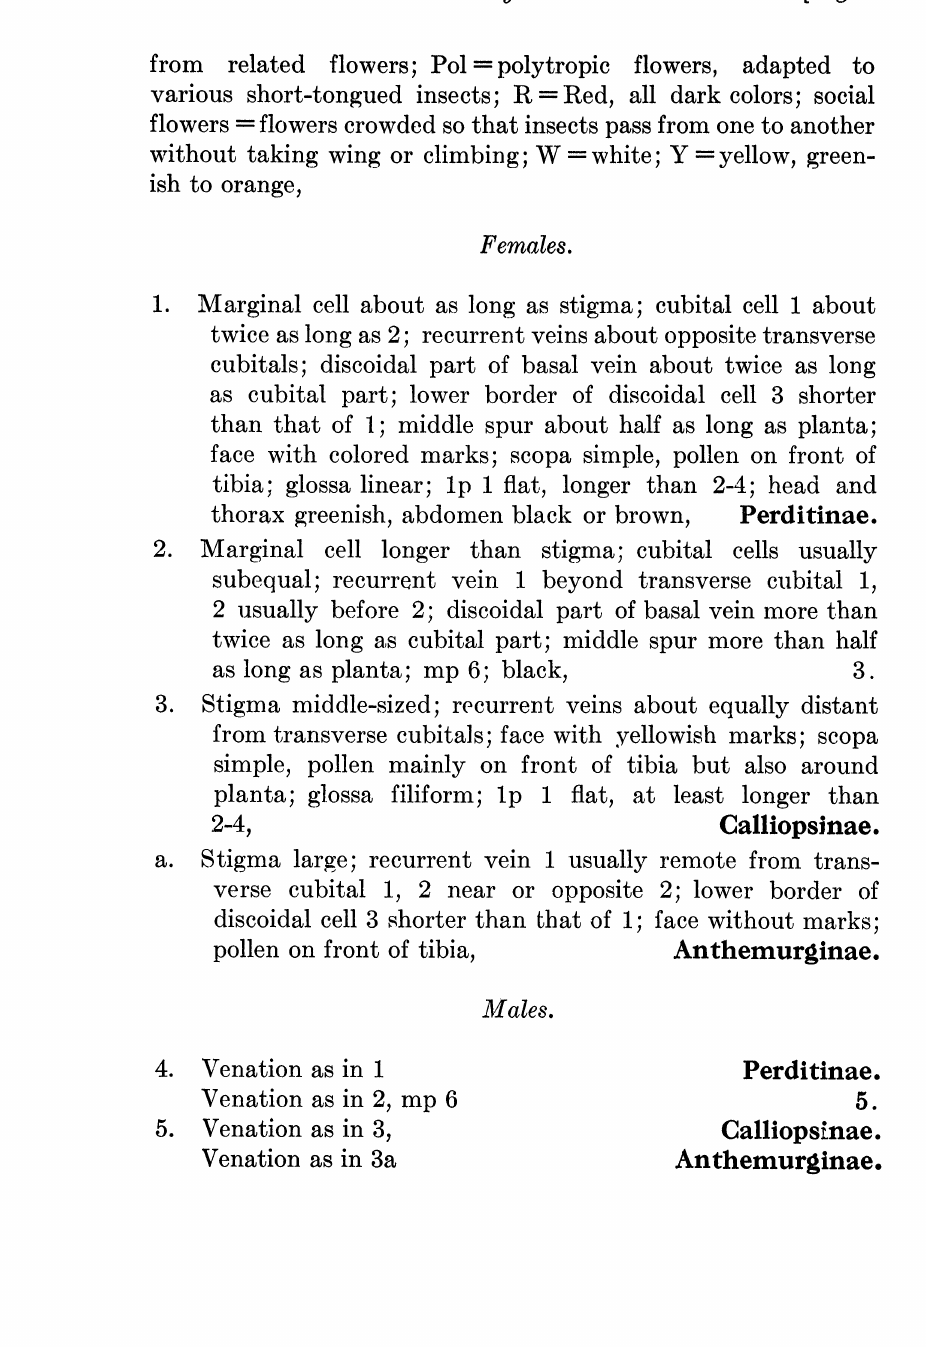
Psyche [August from related flowers; Pol----polytropic flowers, adapted to various short-tongued insects; R--Red, all dark colors; social flowers ----flowers crowded so that insects pass from one to another without taking wing or climbing; W white; Y yellow,